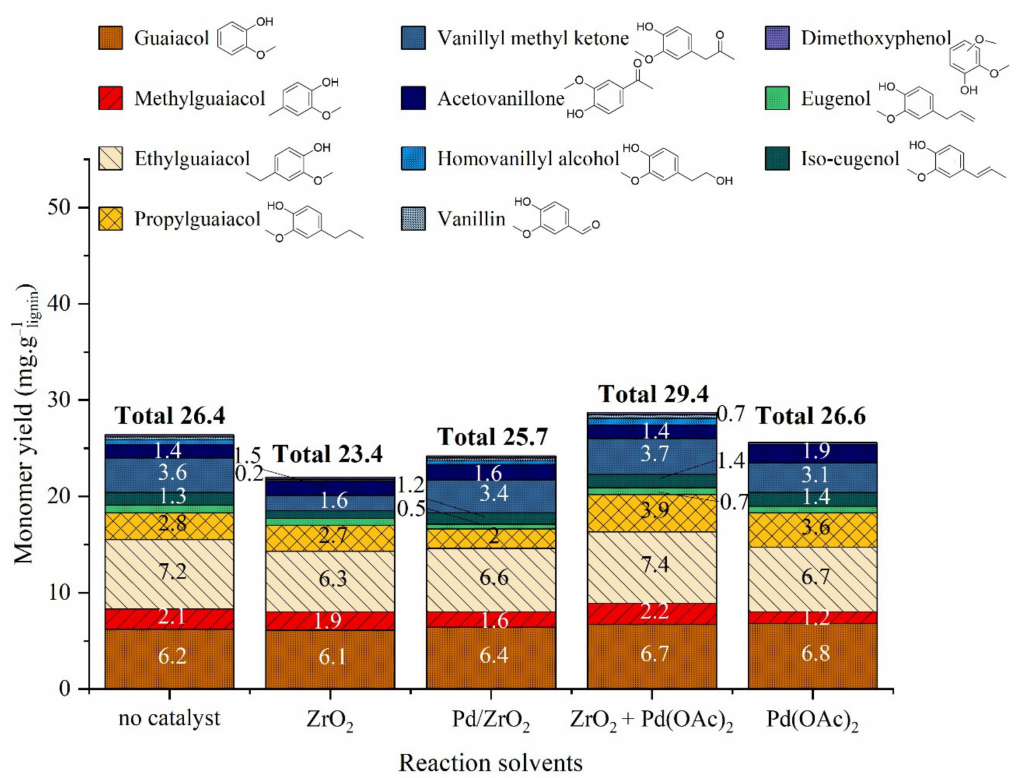
Figure 20. Yield of monomeric products in organic phase after catalytic lignin liquefaction in water/ethanol mixture